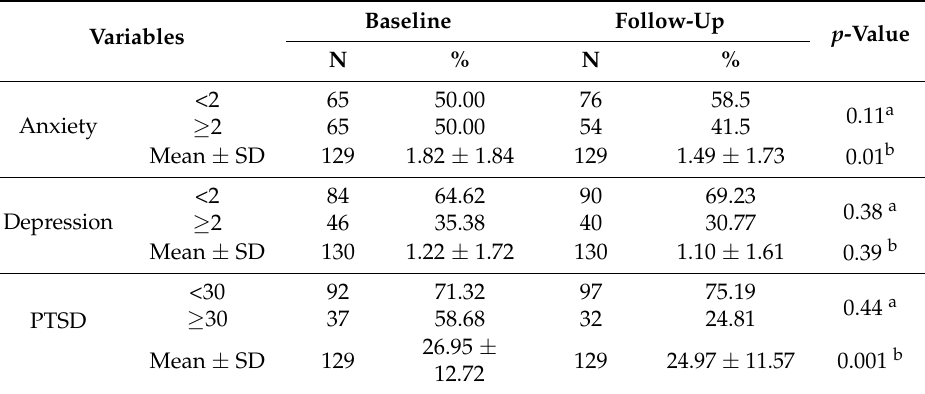
Table 2. Prevalence of mental health symptoms at baseline and